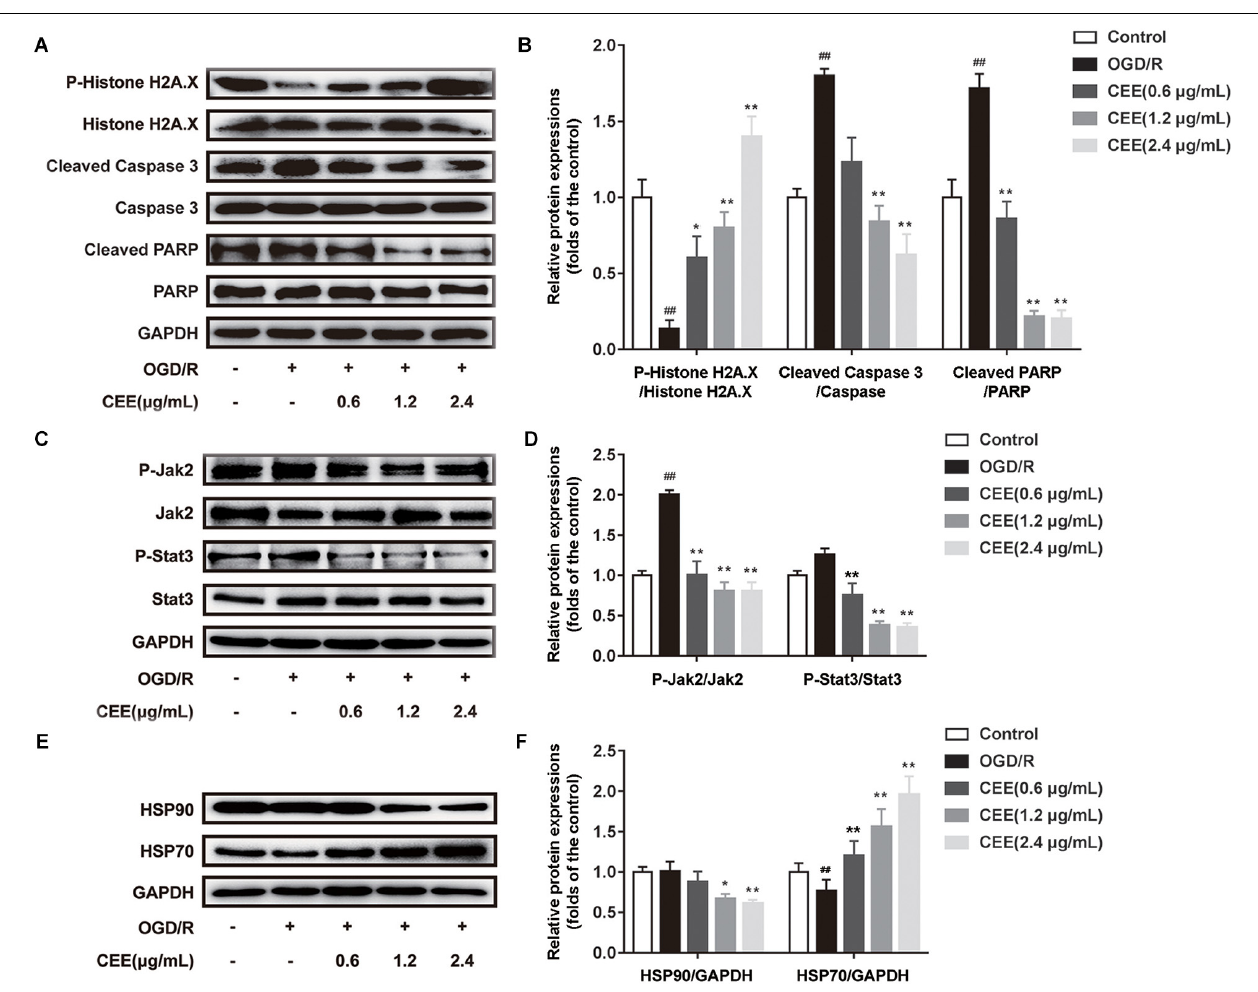
FIGURE 7 | Caesalpinia sappan ethanolic extract protects PC12 cells through the regulation of JAK-STAT, HSP90 and DNA damage/telomere stress signaling pathways. (A) The expression of P-Histone H2A.X, Histone H2A.X, cleaved-PARP, PARP, cleaved-Caspase 3 and Caspase 3 as determined by western blotting. (B) Quantitation of the western blot analysis for P-Histone H2A.X compared with Histone H2A.X, cleaved-PARP compared with PARP, and cleaved-Caspase 3 compared with Caspase 3. (C) The expression of P-Jak2, Jak2, P-Stat3 and Stat3 as detected by western blotting. (D) Quantitation of the western blot analysis for P-Jak2 compared with Jak2, and P-Stat3 compared with Stat3. (E) The expression of HSP90 and HSP70 as determined by western blotting. (F) Quantitation of the western blot analysis for HSP90 compared with GAPDH, and HSP70 compared with GAPDH. Data are expressed as mean ± SD , n = 3. ## P < 0.01 vs. control group, ∗∗ P < 0.01, ∗ P < 0.05 vs. OGD/R